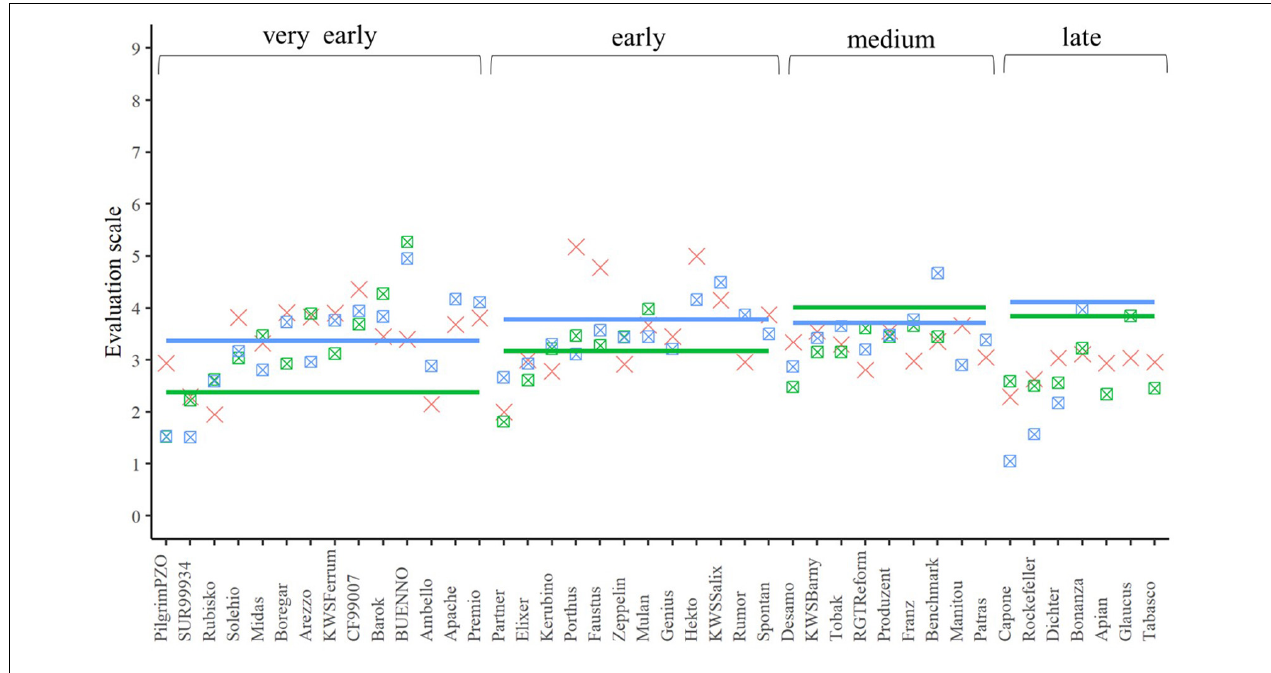
FIGURE 6 | The best linear unbiased estimations of the female (cross), male (line), and their corresponding hybrids (square with cross) for the trait leaf rust resistance. The horizontal bars represent the males in each flowering time group. The males and their offspring have the same color